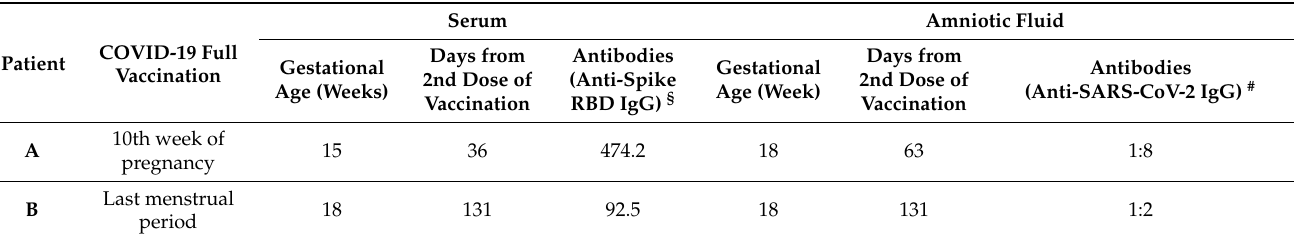
Table 1. Maternal antibody levels in serum and amniotic fluid after second dose of COVID-19